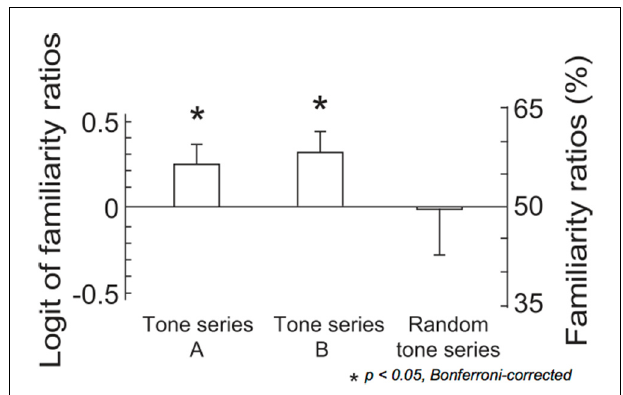
FIGURE 3 | The logit values and percentages of familiarity ratios. In tone series A, tones were sequenced using the constraint that was applied in the last third of the ignored sequence. In tone series B, tones were sequenced using the constraint that was applied in the last third of the attended sequence. In the remaining 10 series, tones were pseudo-randomly sequenced (random tone series). The bars indicate the standard error of the mean. Asterisks indicate significant differences in a pairwise test ( p < 0.05, Bonferroni-corrected).